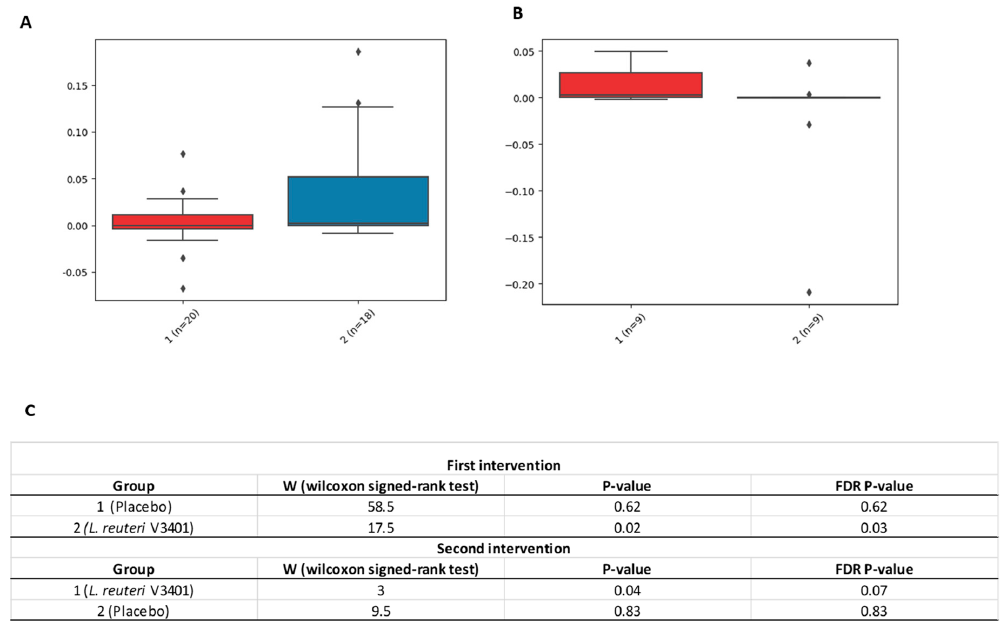
Figure 5. Relative abundance of the delta values of Verrucomicrobia phylum. The box plots indicate the relative abundance of Verrucomicrobia phylum between the final and the beginning points of each intervention—t3-t1 ( A ) and t6-t4 ( B )—due to the treatment and the number of patients (n) of each group and treatment. ( A ) shows data for the first part of this intervention study (First intervention, 1: placebo; 2: L. reuteri V3401), whereas ( B ) shows data from the intervention after the crossover (Second intervention, 1: L. reuteri V3401; 2: placebo). ( C ) describes the Wilcoxon signed-rank test values and the significant levels by means of p and FDR p -values. FDR: False discovery rate; (cid:7) : outliers data